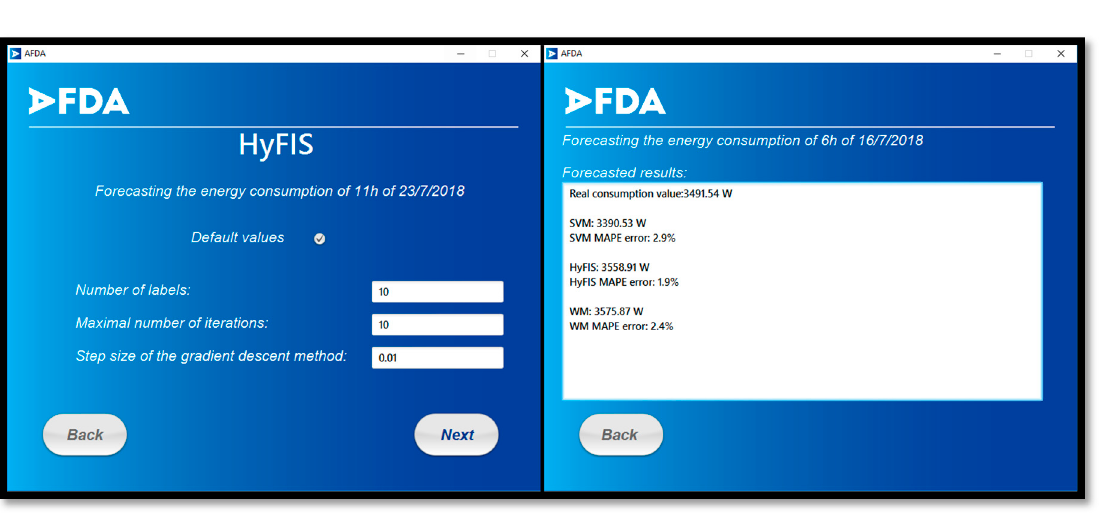
Figure 10. The Information picker and strategies explanation pages.